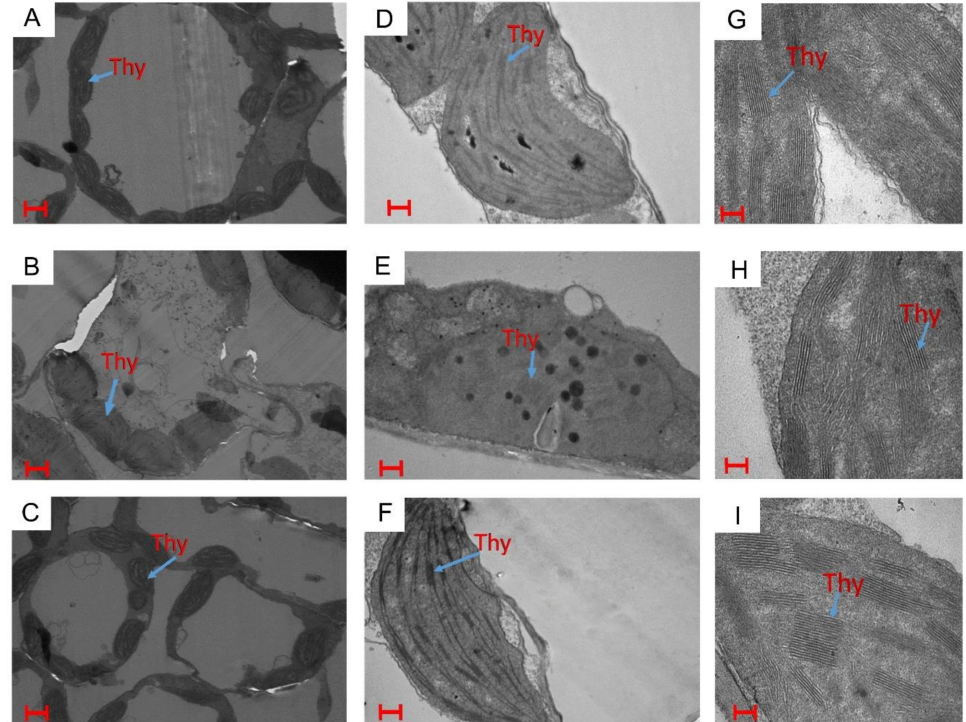
Figure 3. Ultrastructure of chloroplasts in mustard leaves using transmission electron microscopy at a magnification of 1.2 kx ( A – C ), 6.0 kx ( D – F ) and 15.0 kx ( G – I ) under ( A , D , G ) control, (BEH) 100 mM NaCl, and ( C , F , I ) 200 mg S kg − 1 soil + 200 µ l L − 1 ethephon with 100 mM NaCl at 30 d after sowing. Bars ( A – C ) = 500 nm; bars ( D – F ) = 100 nm; bars ( G – I ) = 20 nm. Thy = thylakoid